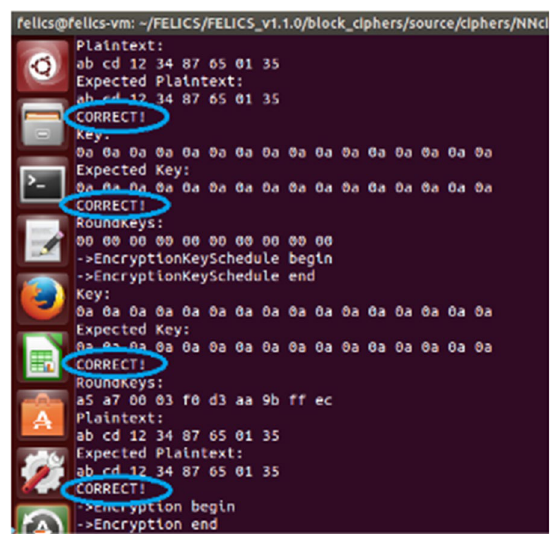
Fig. 10 The FELICS implementation to verify the RBFK